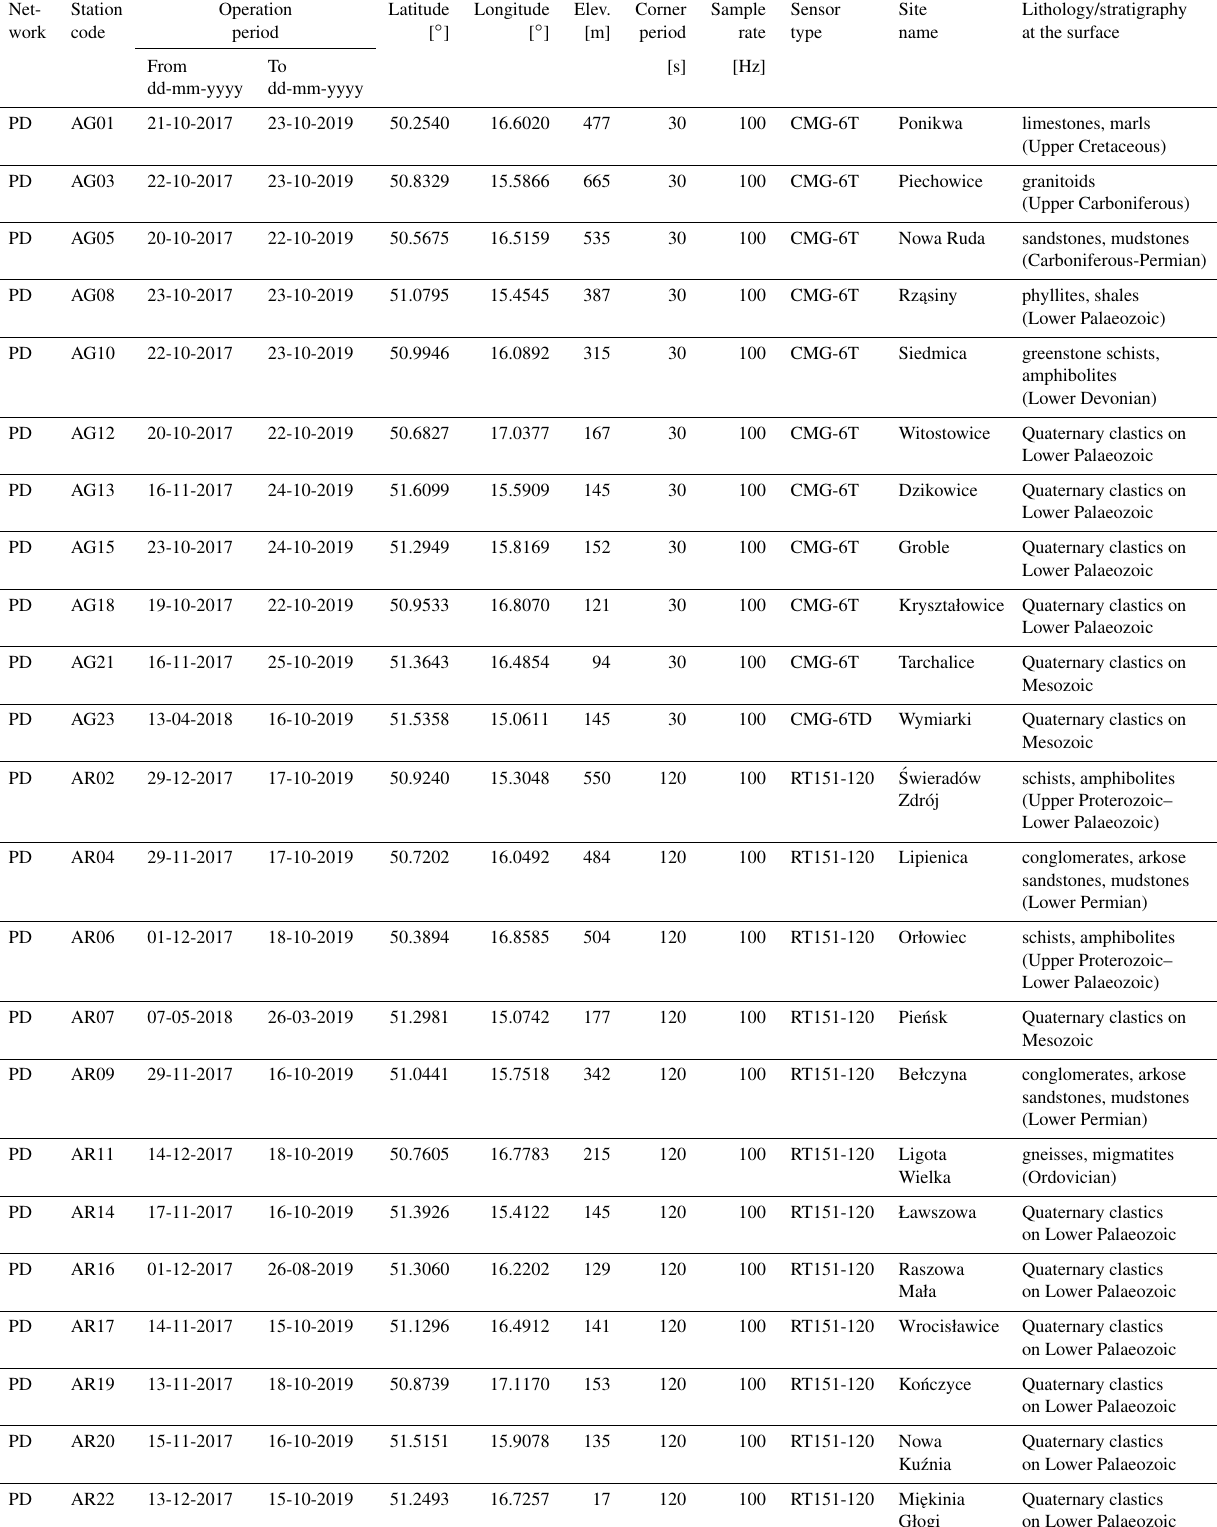
Table 1. Location and technical parameters of the temporary and permanent stations used in the experiment, with lithology and stratigraphy information for observation